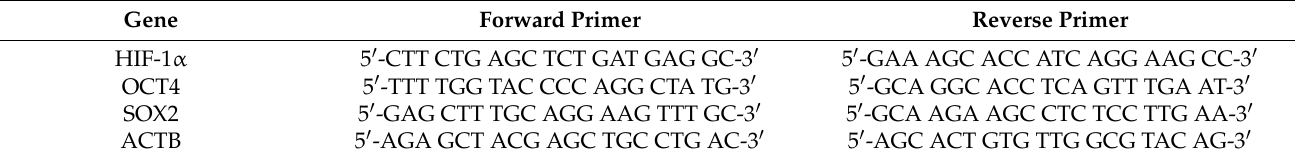
Table 1. Primer Sequences used for